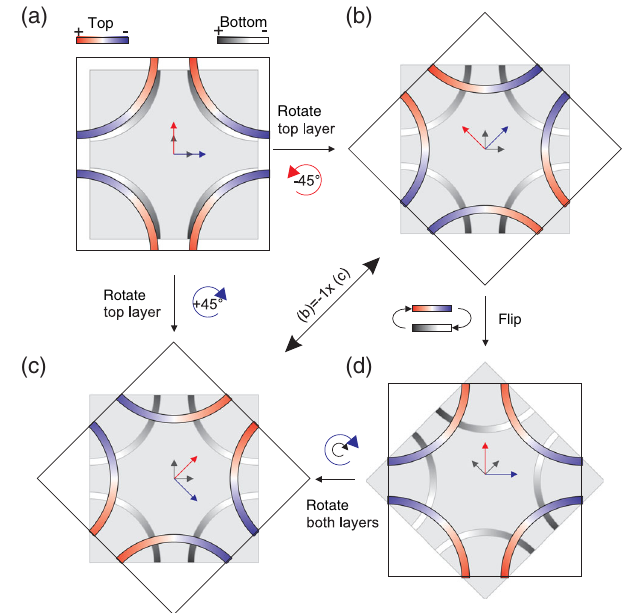
FIG. 7. (a) Illustration of the CuO 2 bands in the first Brillouin zone around the Γ point. The top (bottom) layer of CuO 2 is represented by blue and red (black and white) colors. The change from blue (black) to red (white) reflects the sign change of the order parameter. (b),(c) Tunneling element in the two cases where the top CuO 2 layer is rotated clockwise or counterclockwise by 45°. The minus sign between them indicates that the situation of (b) transforms to that of (c) by multiplying a factor of − 1 . (d) This tunneling situation is obtained by viewing the tunneling element shown in (c) from the back side. It transforms back to (b) by rotating the top and bottom layer together by